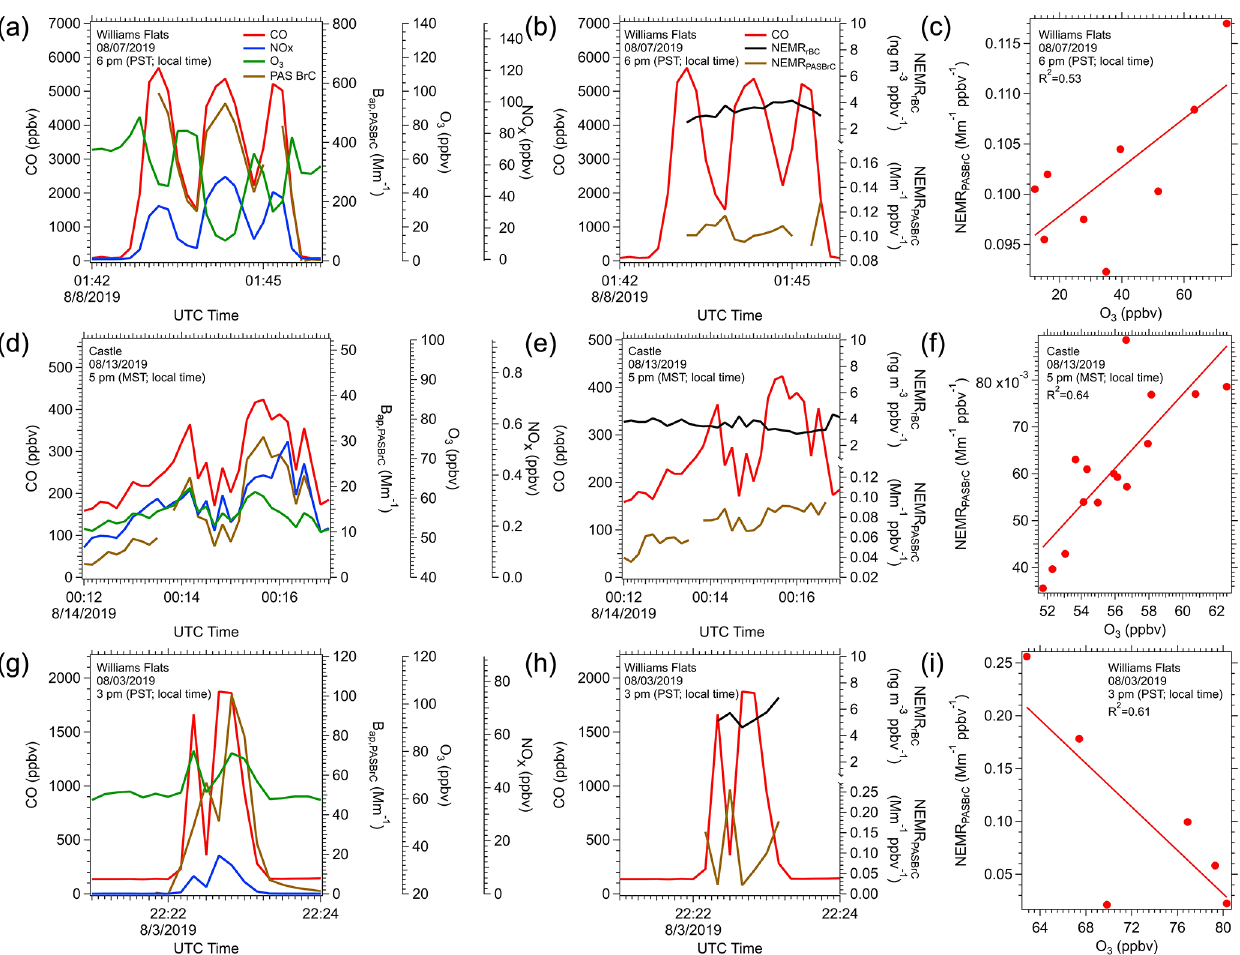
Figure 12. Time series for the concentration of CO (red), BrC from the PAS (brown), O 3 (green) and NO x (blue) in three example plume- transects in plots (a) , (d) and (g) . Corresponding time series for NEMR BC (black) and NEMR BrC (brown) for these transects in (b) , (e) and (h) and the relationship between NEMR BrC and O 3 for each of these periods of in-plume sampling in (c) , (f) and (i)